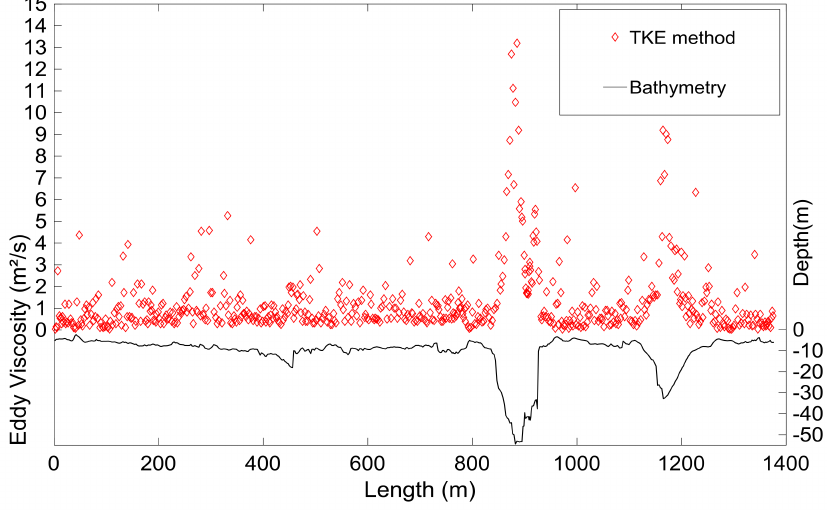
Figure 10. Eddy viscosity distribution over the cross-section, using the TKE